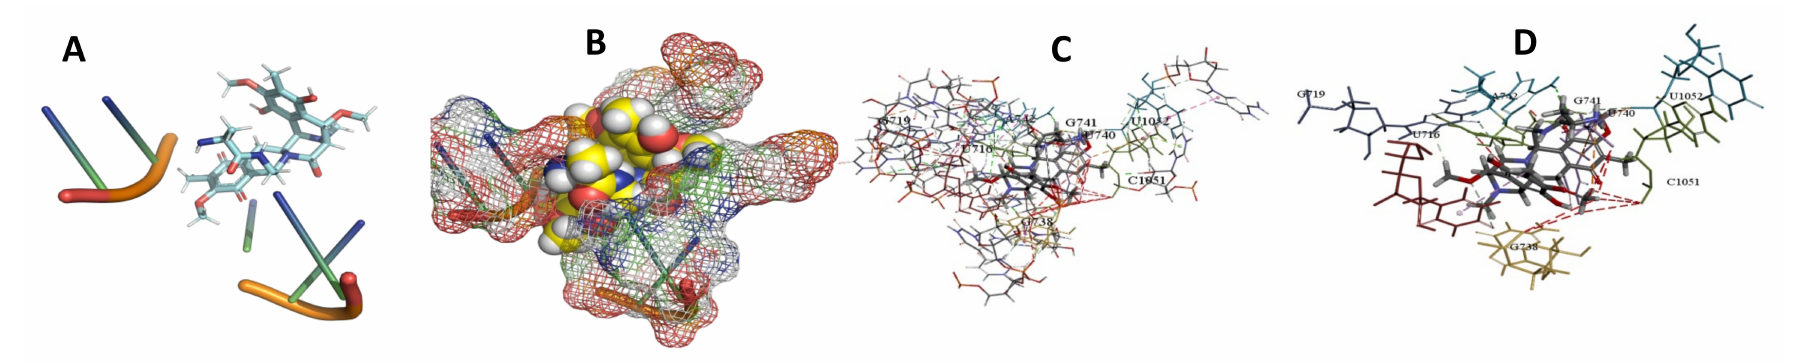
Figure 17. T. cruzi + cittilin. ( A ): Best binding pose and nucleotides involved. ( B ): Schematic binding pocket. ( C ): shows the Nucleotides component that re involved in binding. ( D ): Shows the main bonds involved between the compound and the nucleotide